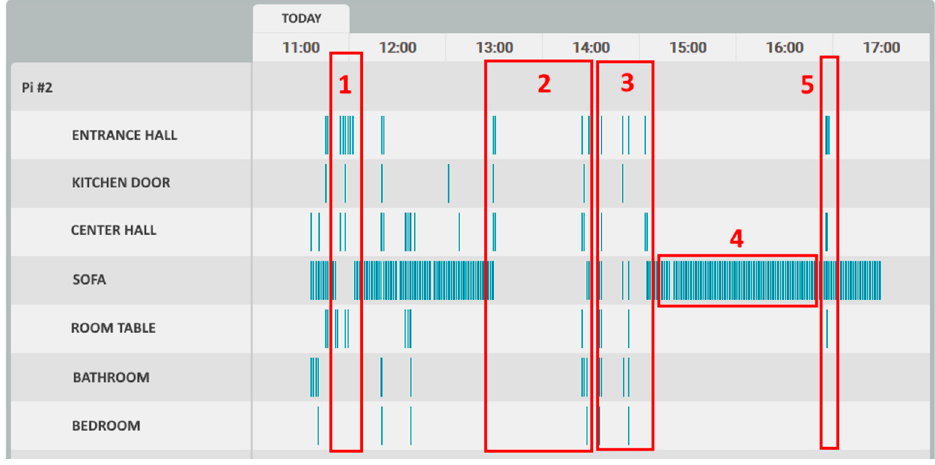
Figure 17. Timeline interpretation.